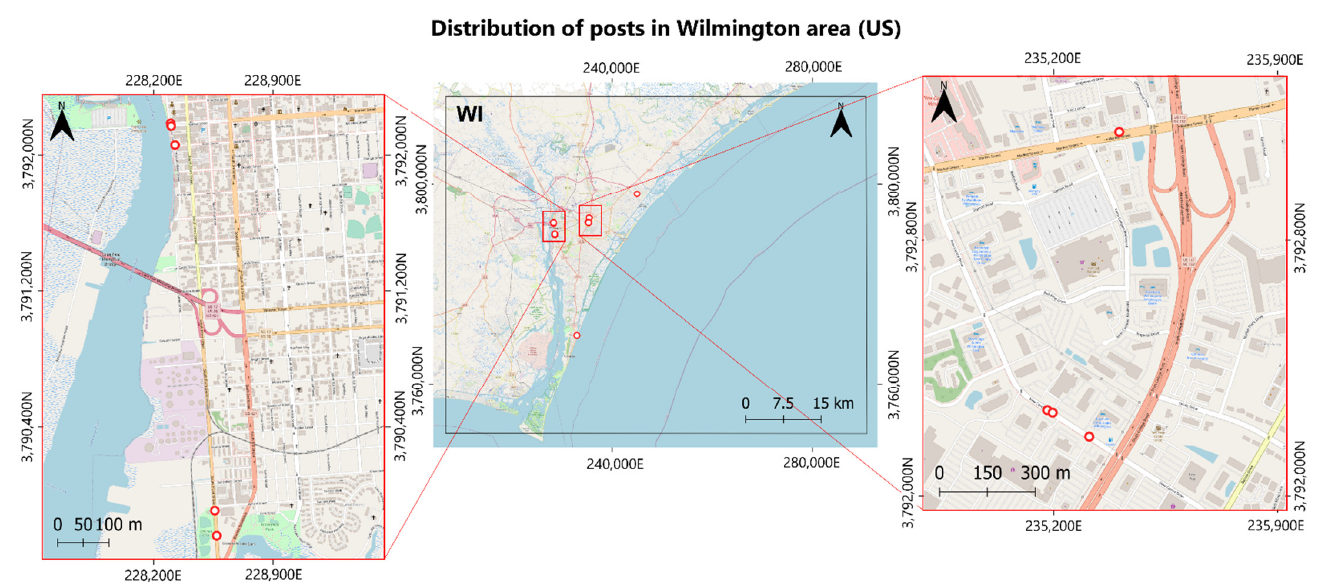
Figure 5. Distribution of posts used to build floodwater training samples for the Wilmington area (US). CRS: WGS84/UTM zone 18 N. Basemap data: OpenStreetMap contributors.